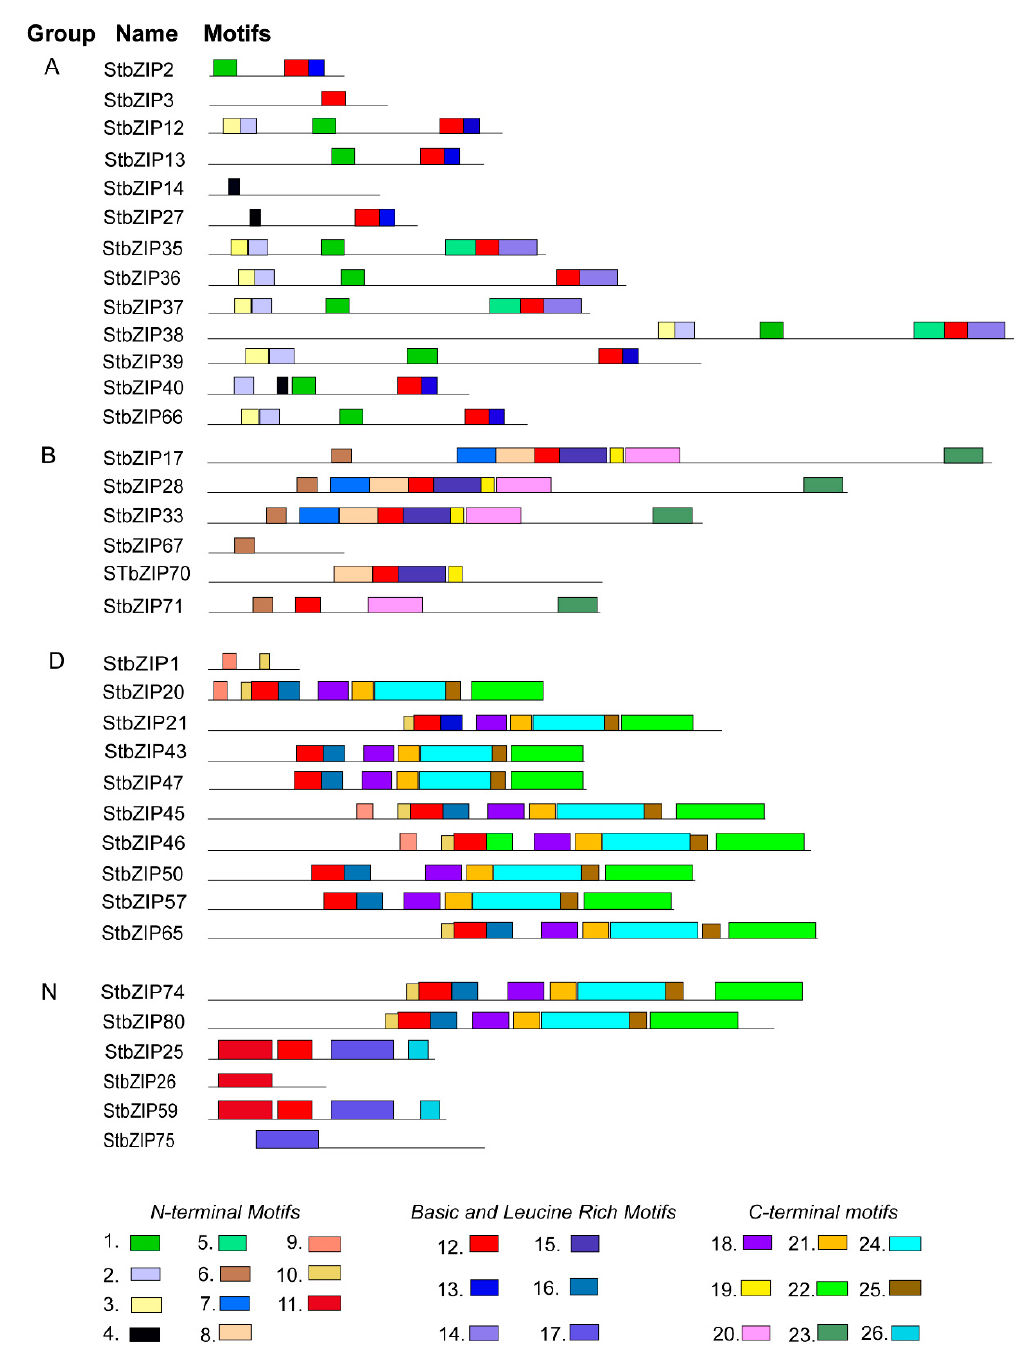
Figure 5. Conserved motifs identified using MEME software suite. All factors, except six, were predicted to have one bZIP domain ( p < 0.001). The conserved basic N-X (7)-R/K motif is colored red, and adjoining leucine-rich motifs are shaded blue. Figure S1 provides the details for all motifs in this figure.